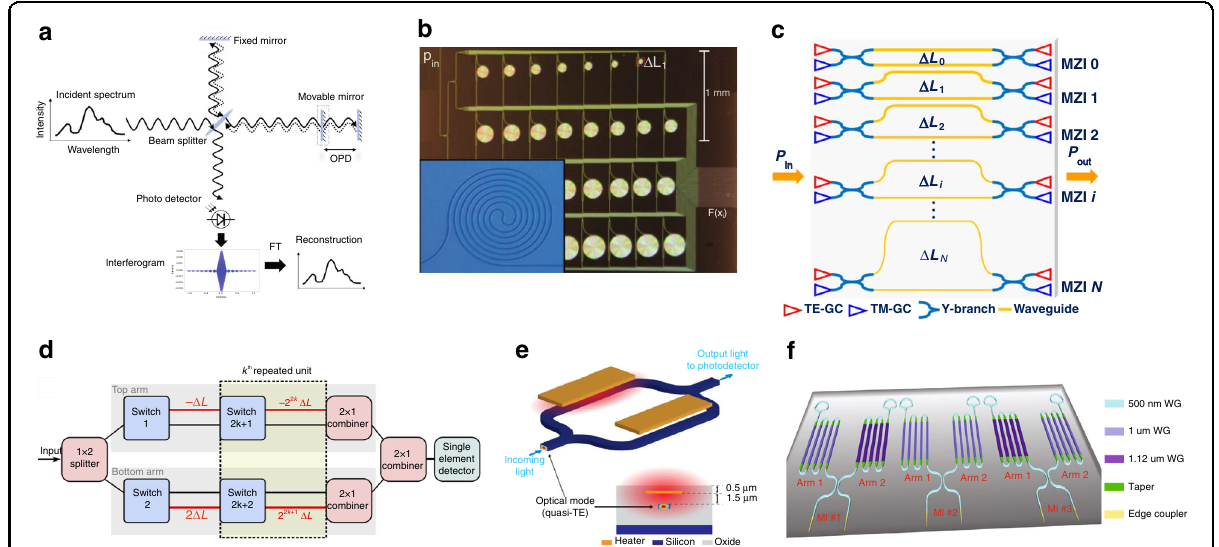
Fig. 10 Fourier transform spectrometers on silicon photonics platform. a General framework of a FTS 17 . b , c FTS on silicon photonics with OPDs introduced by an array of imbalanced MZIs 15,83 . d , e FTS on silicon photonics with OPDs tunable in time domain 16,118 . f The state-of-the-art work on silicon TH-FTS with 180 nm bandwidth and 0.16 nm resolution 17 . a Reprinted from ref. 17 with permission from John Wiley and Sons. b Reprinted with permission from ref. 83 . © Optica Publishing Group. c Reprinted with permission from ref. 15 . © Optica Publishing Group. d Reprinted by